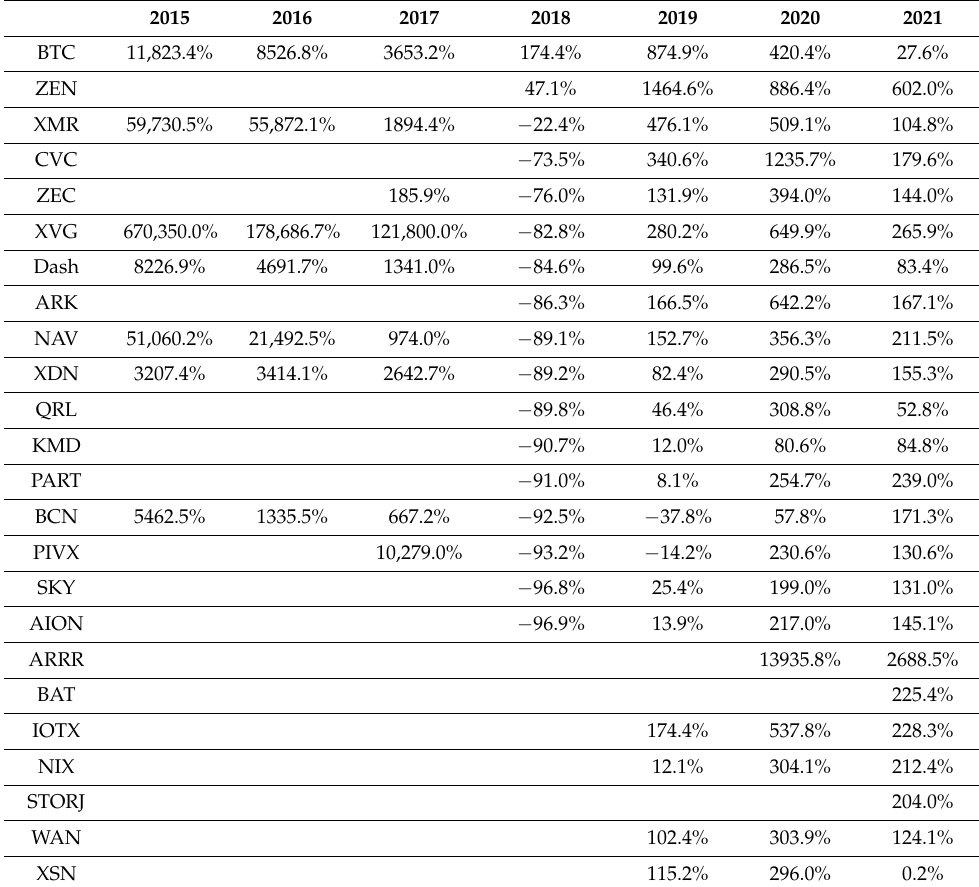
Table 2. Price development of Bitcoin and privacy coins from the beginning of different years to